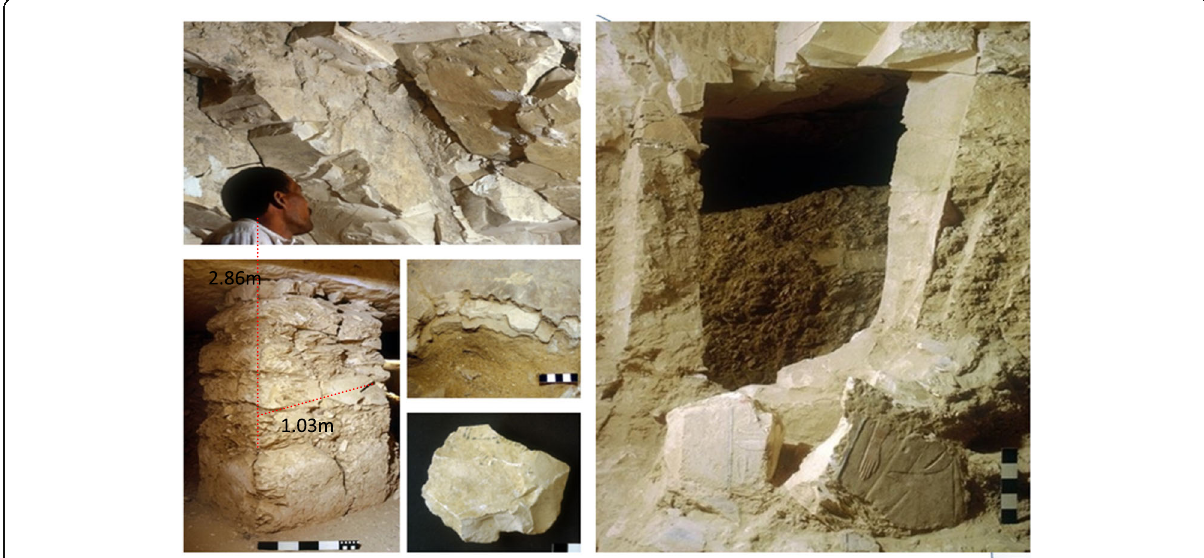
Fig. 8 Extensive structural damage in KV5. Engineering failure of the structural pillars, sidewalls and Ceiling of the Corridors and Chambers in the